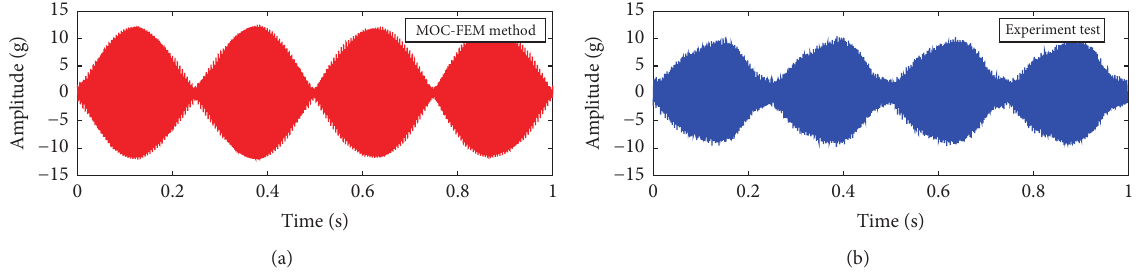
Figure 9: Pipeline vibration response under multiexcitations.